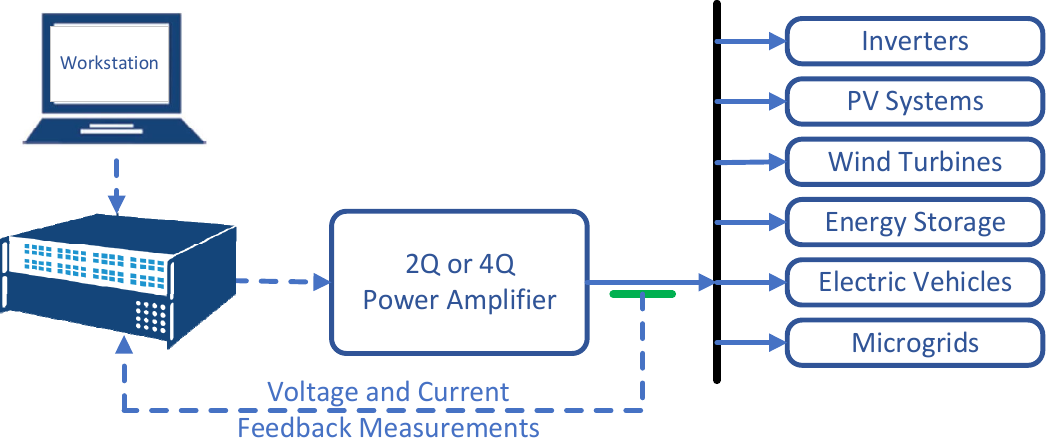
Figure 5. Schematic of example PHIL setup, adapted from [56].